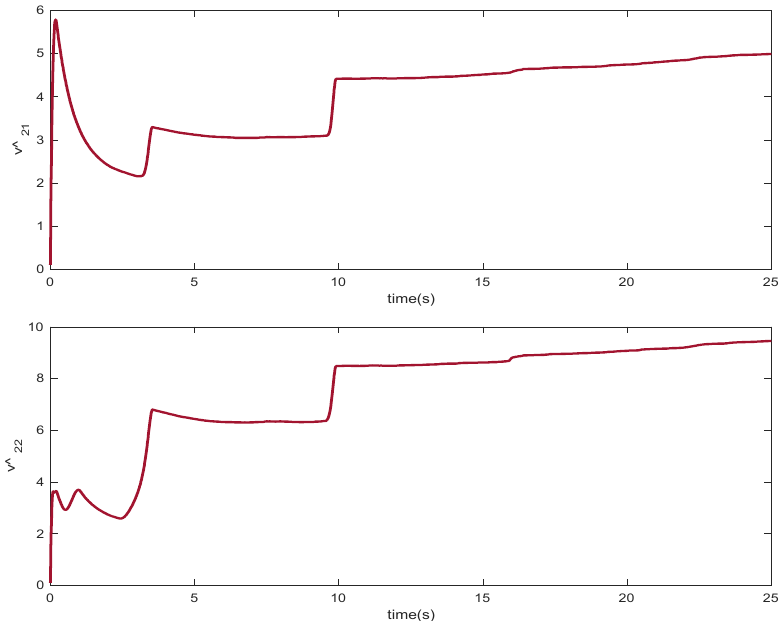
Figure 13. Adaptation laws ˆ ν 21 , ˆ ν 22 in Scenario